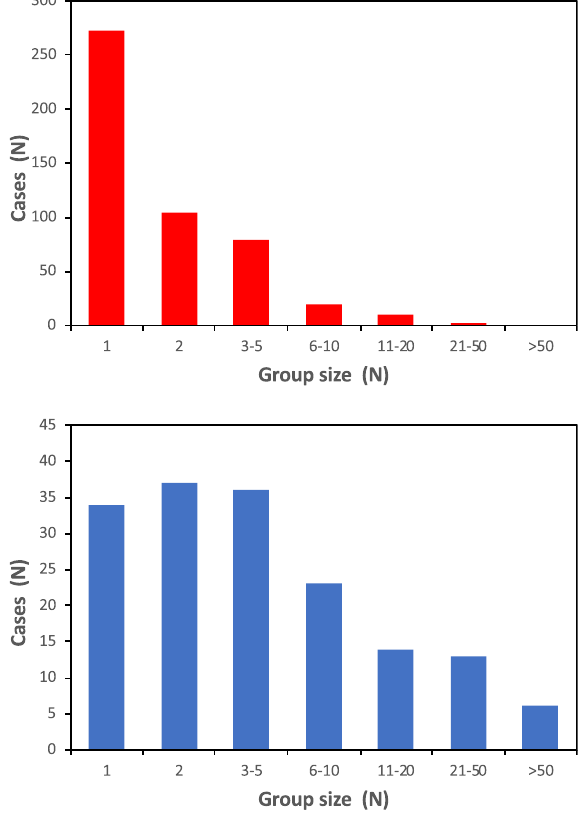
Figure 2. Distance sampling: group size in breeding (red) and winter (blue)